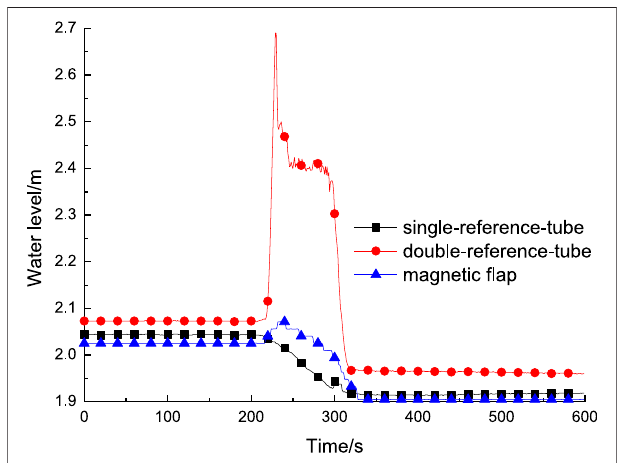
FIGURE 9 | Vessel pressure of slow depressurization.